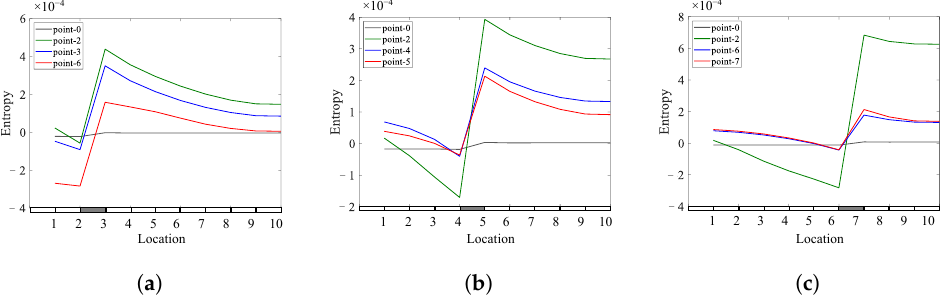
Figure 31. The effect of changing excitation locations on the Shannon entropy of a simply supported with a single breathing crack: ( a ) q 1 = 0.25; ( b ) q 2 = 0.45; ( c ) q 3 =